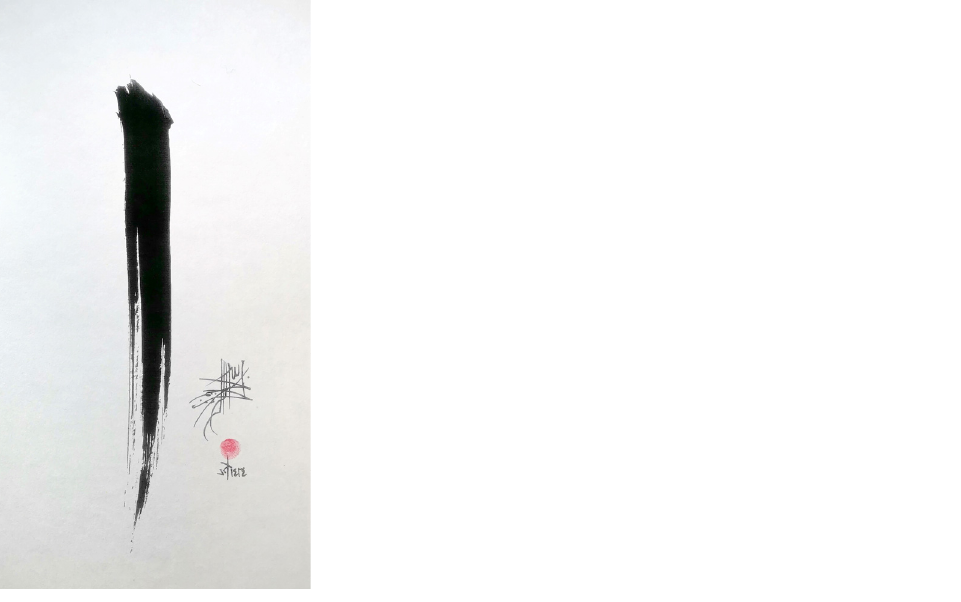
Figure 2. Ahmed Kreusch, Alif , 2004. Ink on paper. 12 × 24 cm . © Ahmed Kreusch.